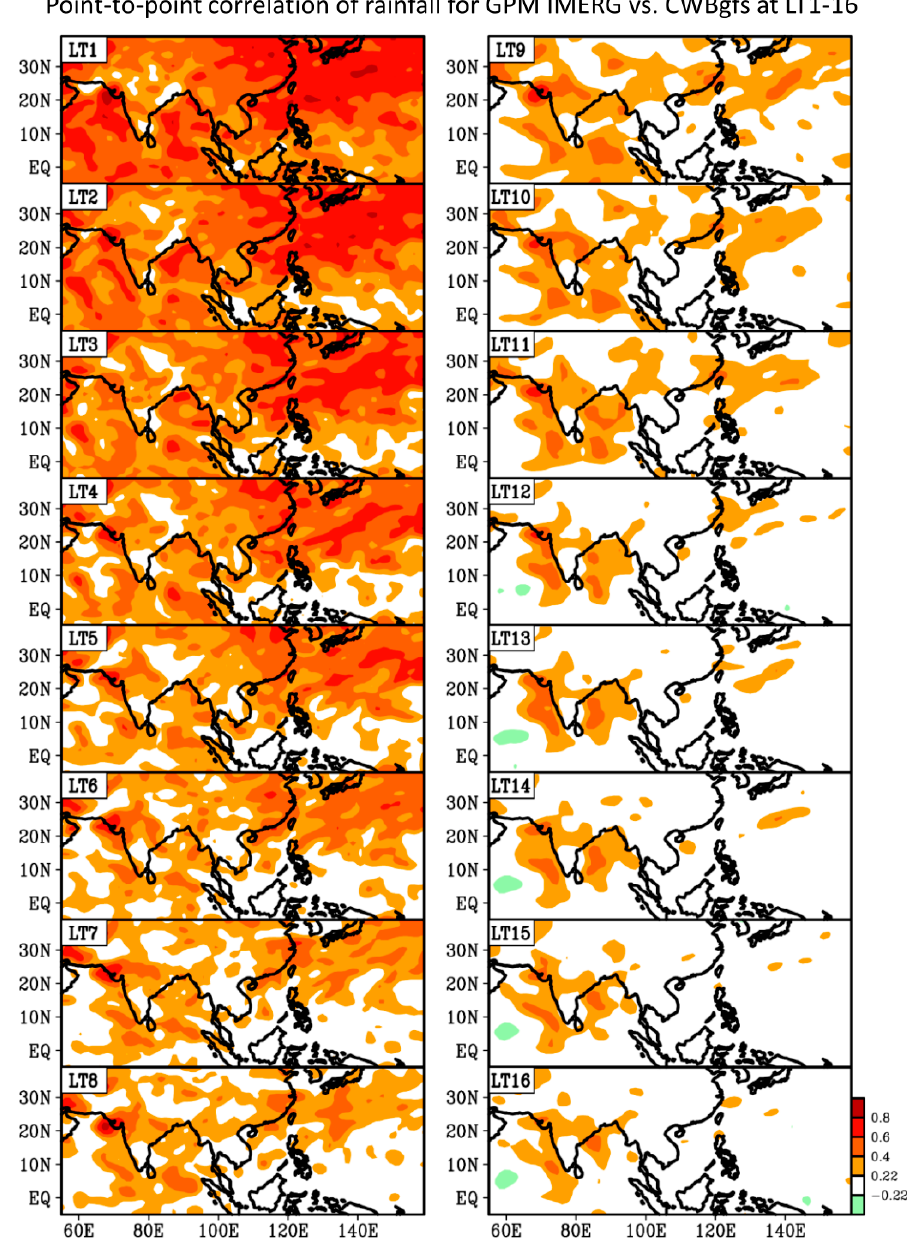
Figure 13. Similar to Figure 12, but for the point-to-point temporal correlation between the observation and the CWBgfs forecast daily rainfall (at lead times of 1 day to 16 days; LT1~16) during the 2017 Meiyu season. Only the areas with correlation significant at the 90% confidence interval are shaded.